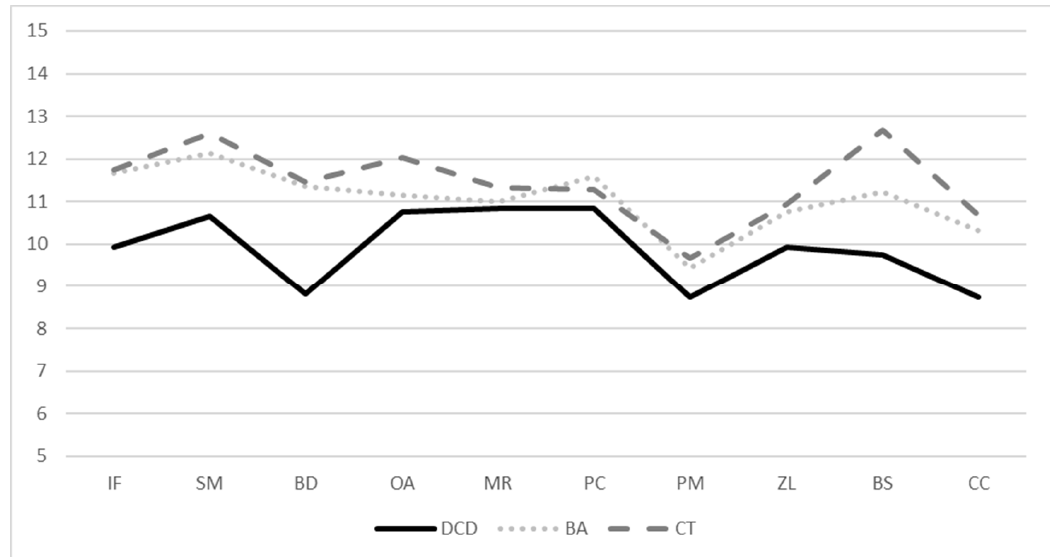
Figure 2. Mean scores of the ten primary WIPPSI-IV subtests (scaled scores). Note: IF = Information, SM = Similarities, BD = Block Design, OA = Object Assembly, MR = Matrix Reasoning, PC = Picture Concepts, PM = Picture Memory, ZL = Zoo Locations, BS = Bug Search, CA = Cancellation.